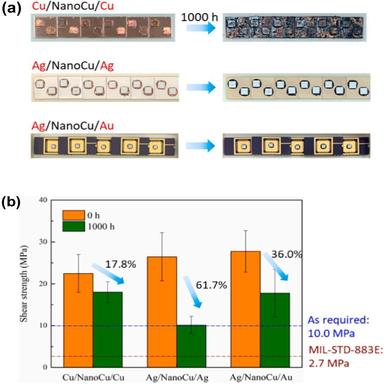
(a) Optical microscopy and (b) shear strength of nanoCu sintered joints on various metallizations and substrates after thermal aging at 300 ◦C for 1000 h.